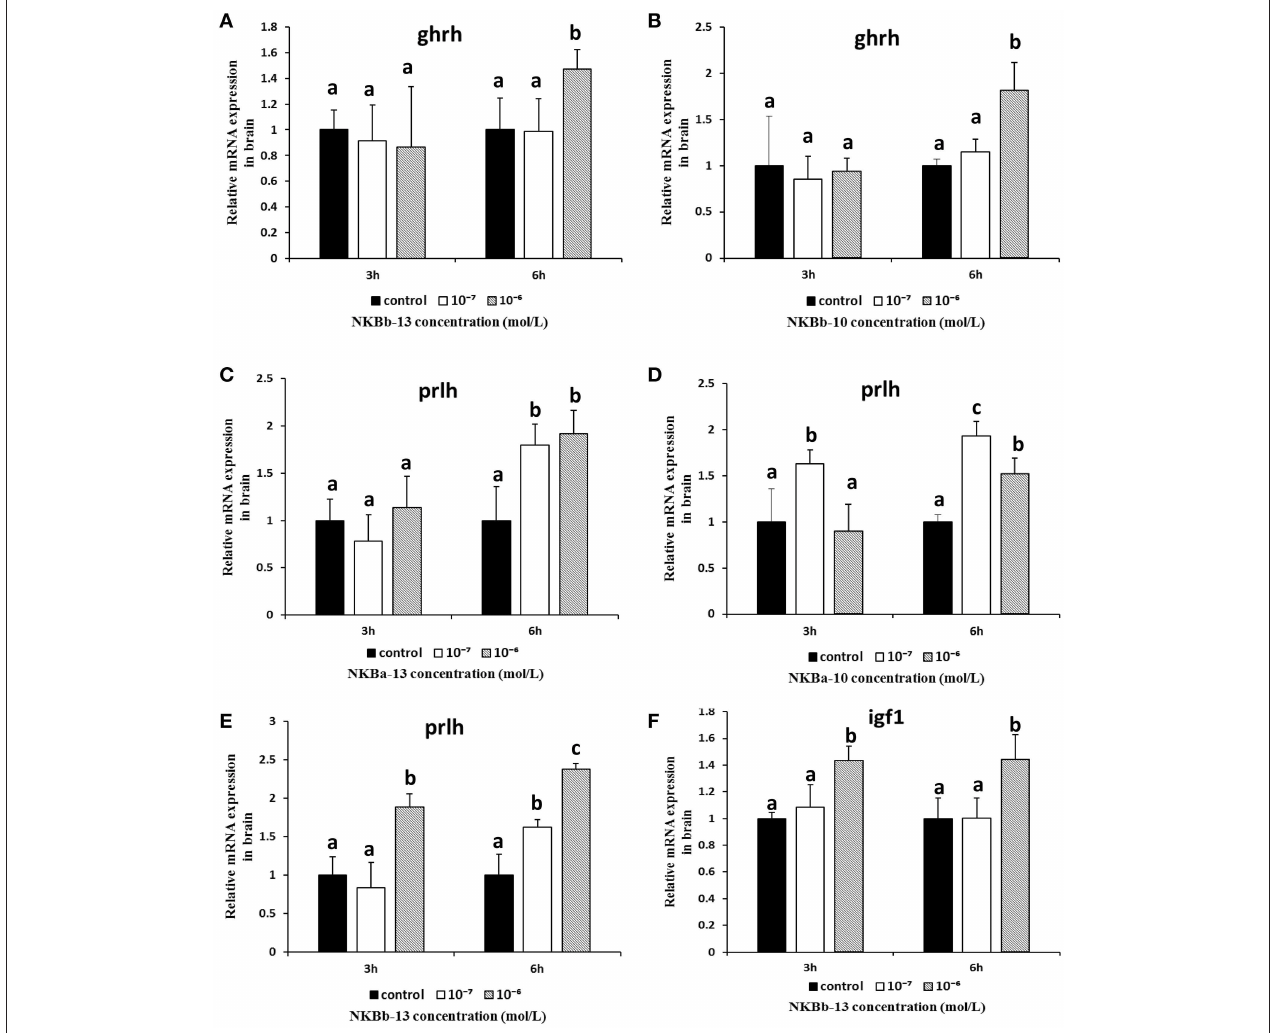
FIGURE 11 | Effect of NKBs on the expression of growth-related genes in the brain. The X axis indicates hours after NKB treatment. (A,B) Effect of NKBb-13 and NKBb-10 on the mRNA levels of ghrh in the brain. (C–E) Effect of NKBa-13, NKBa-10, and NKBb-13 on the mRNA levels of prlh in the brain. (F) Effect of NKBb-13 on the mRNA levels of igf1 in the brain. The results were represented as the mean ± SEM and expressed as fold of the expression level in controls. Significant differences are noted by different letters for each concentration ( P <